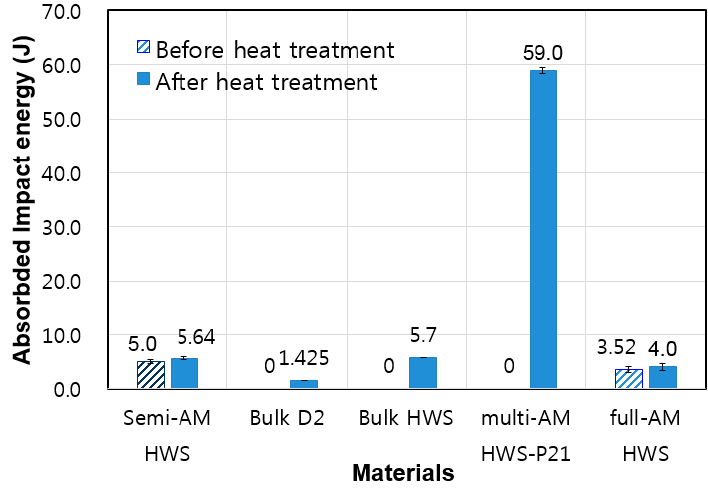
Figure 10. The impact absorber energy comparison of the five materials.